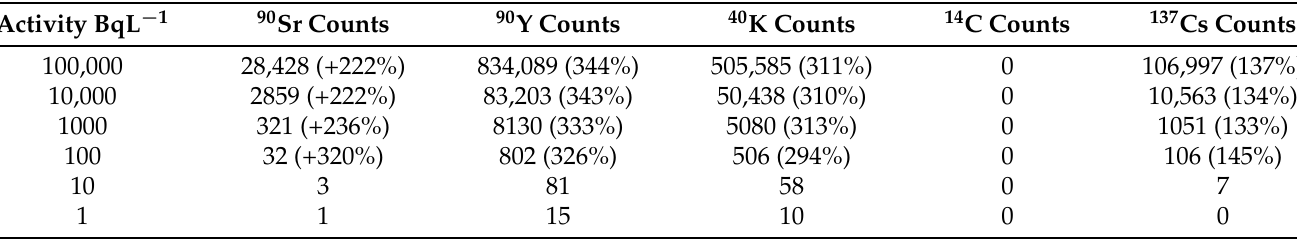
Table 3. The counts observed in a gallium-arsenide (GaAs) sensor for various radionuclides found at Sellafield, and the percentage increase compared to the CdTe sensor.